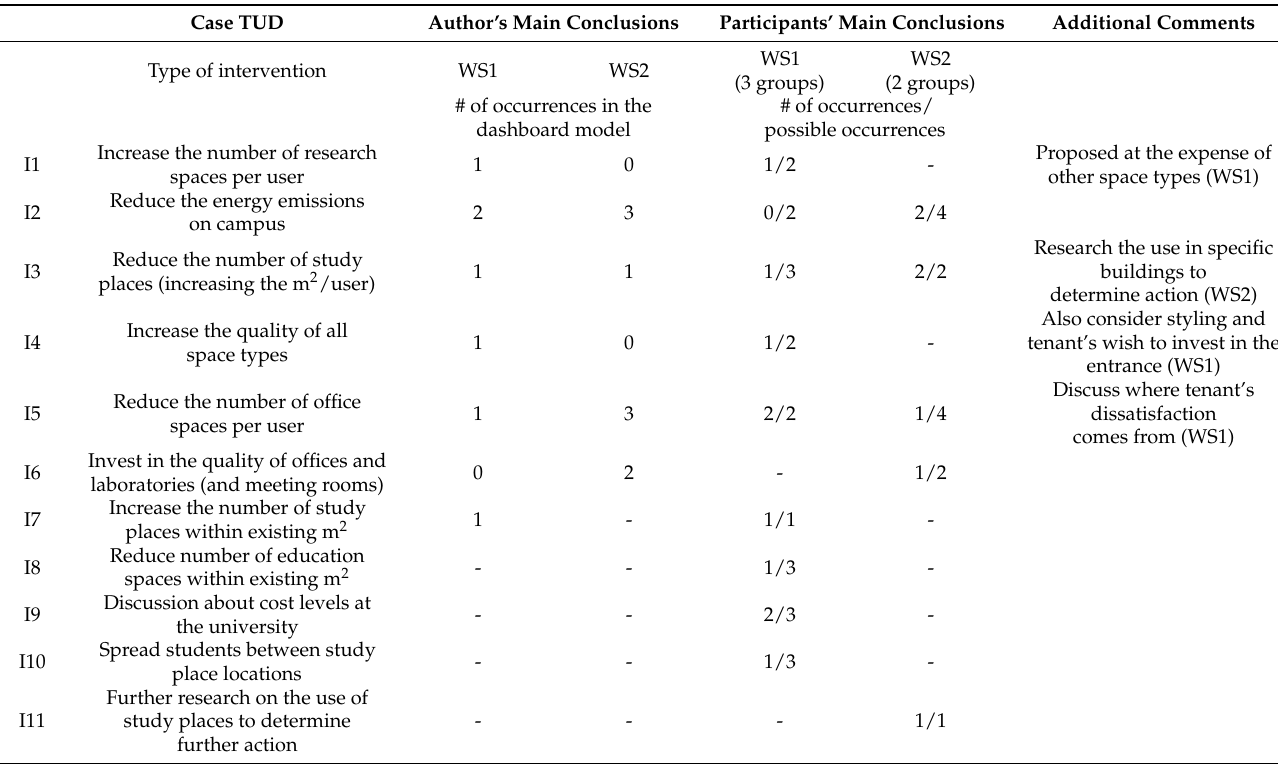
Table 4. Interventions in Case TUD for the buildings that were selected by the participants in the assignments. Case